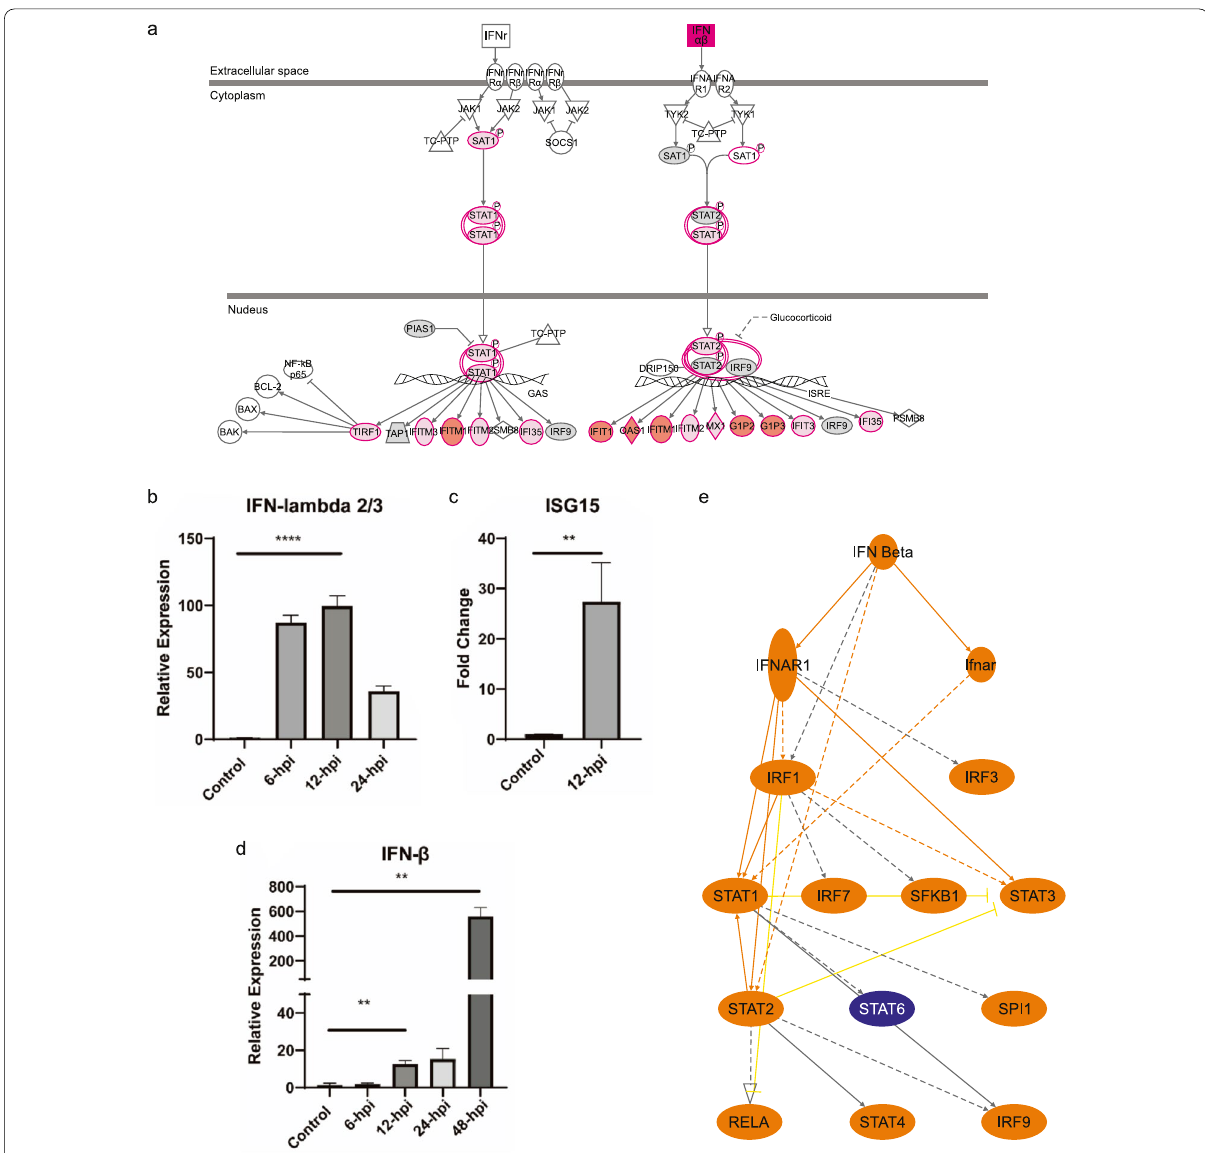
Fig. 9 Regulation of induced immune genes expression in human brain microvascular endothelial cells (hBMECs) following influenza A virus infection. a Canonical pathway of the “Interferon signaling” for the genes differentially expressed in hBMECs 12 hpi, genes that are significantly up-regulated are shown in red. The intensity of red corresponds to an increase in fold change levels of the cells infected with A/WSN/33 (H1N1) compared to the control cells z-score 4.2. White nodes specify genes with no significant gene expression at 12 hpi. The pathway was generated = with IPA (Ingenuity pathways system). b quantification of gene expression by (RT-qPCR) for IFN-λ 2/3 ( c ) ISG15, and d IFN-β. (b-d) the hBMECs were infected with A/WSN/33 (H1N1) at MOI 0.1, and the target genes were quantified by relative quantification qPCR. statistical-significance analyzed by t-test * p < 0.05, ** p < 0.01, and **** p < 0.0001. e Mechanistic network by IPA for the upstream regulators interacting with IFN-β, which enables to discover plausible sets of connected upstream regulators that can work together to elicit the gene expression changes observed in our